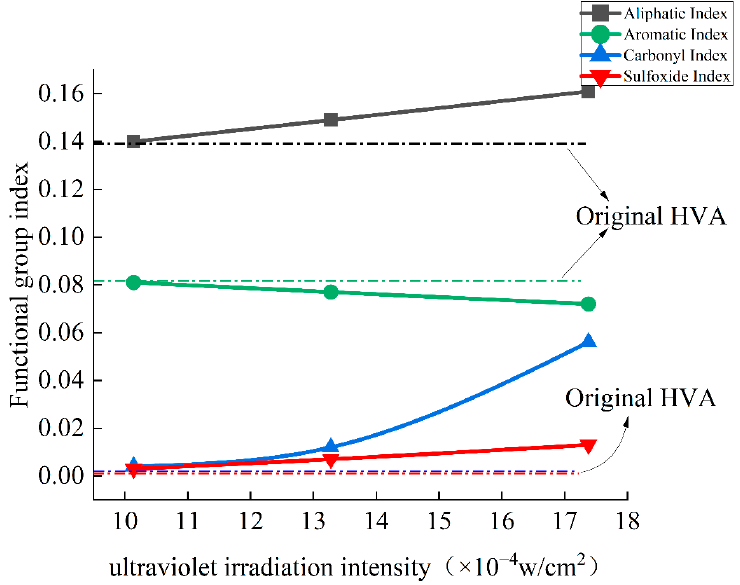
Figure 4. Variation of characteristic functional group index under different ultraviolet irradiation